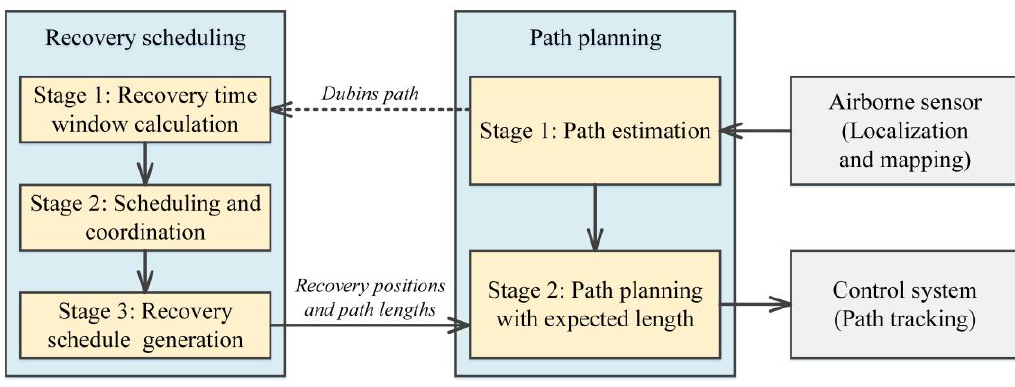
Figure 2. Recovery planning framework.